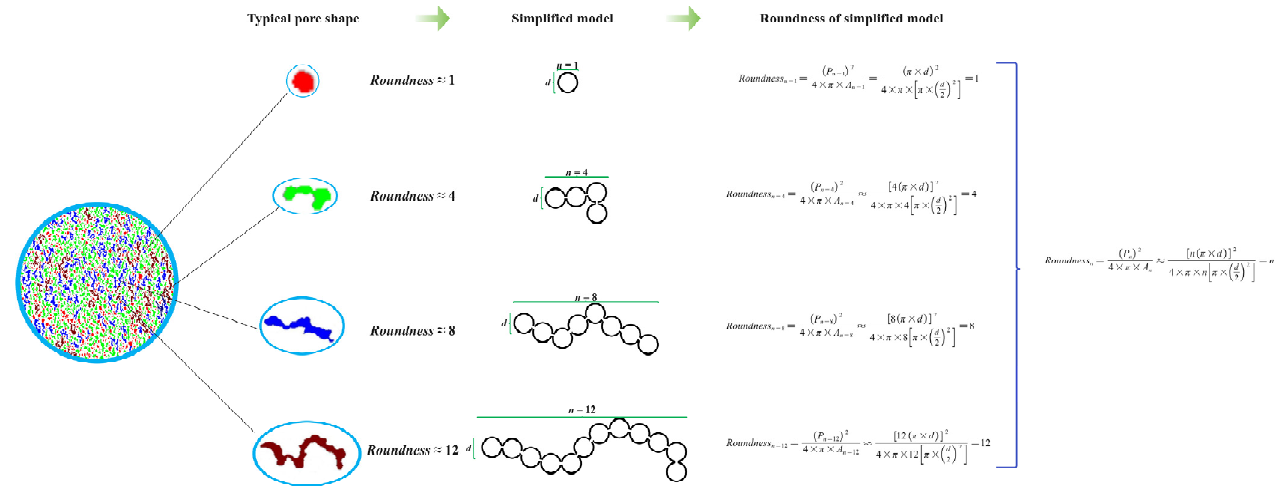
Figure 15. A simplified interconnected pore models of geopolymer foams.